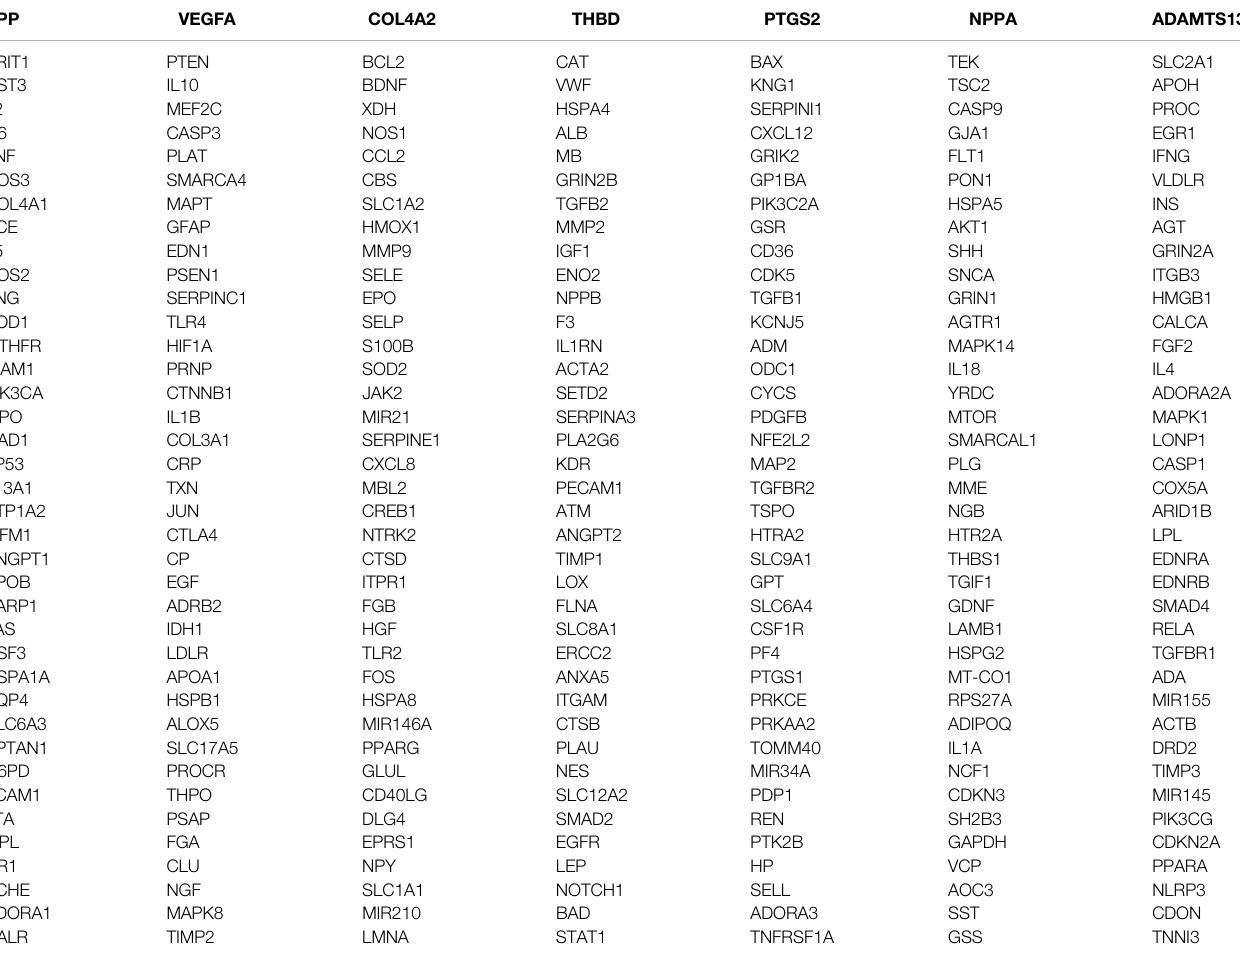
TABLE 2 | Partial gene list of cerebral ischemia – reperfusion.